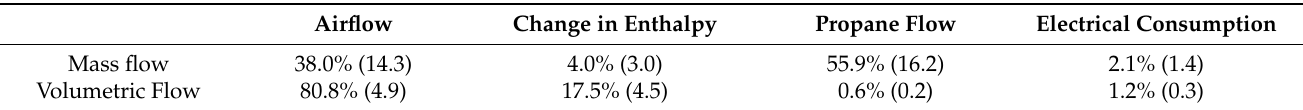
The values in parentheses represent 1 standard deviation of the